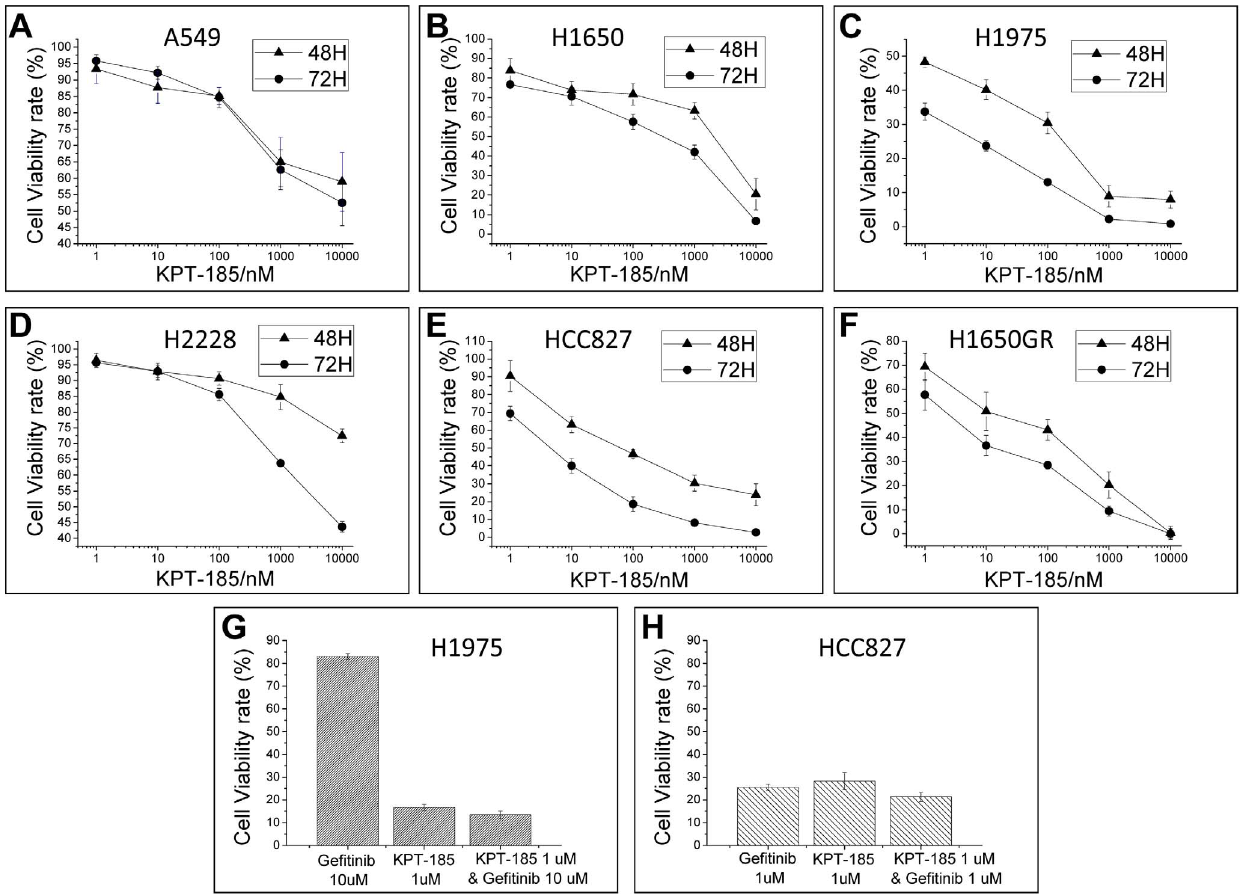
Figure 1. Effect of KPT185 on cell viability in NSCLC cells. Six NSCLC cell lines were treated with KPT-185 for 48 h or 72 h. Cell viability was suppressed by KPT-185 in a dose- and time-dependent manner (A , F). KPT-185 inhibited cell viability in H1975 (G) and HCC827 (H) cells when compared to the effect of EGFR-TKI gefitinib treatment. (N=3).